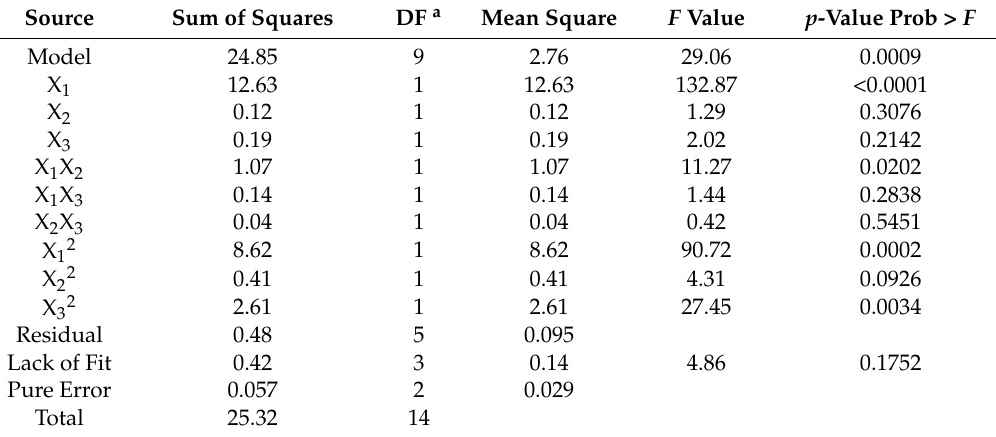
Table 3. Analysis of variance (ANOVA) of the quadratic